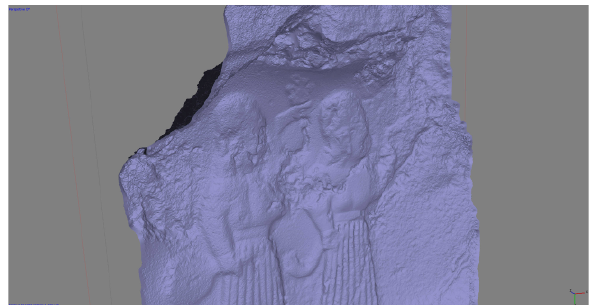
Figure 10. Polygonal Model - Relief of the Chamber A For every typology of model subdivided in this way, an interactive map was created from which, according to a GIS platform logic, which directly enters into the visualization mode.